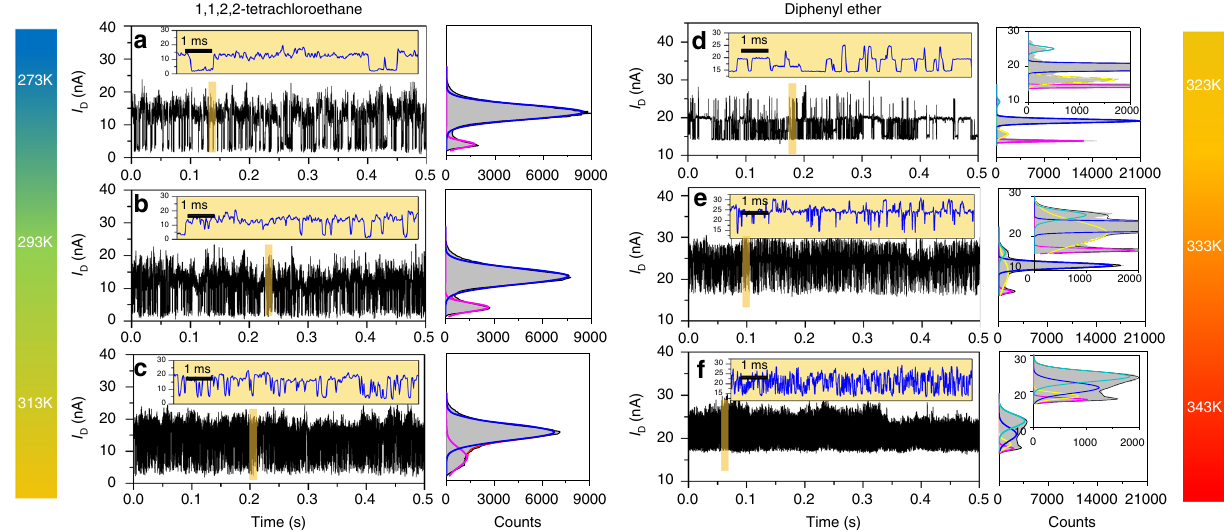
Fig. 3 Temperature-dependent and solvent-dependent measurements of hydrogen bond dynamics. I – t curves and the corresponding histograms of a HBB- SMJ device immersed in TeCA at 273 K ( a ), 293 K ( b ) and 313 K ( c ), and in diphenyl ether at 323 K ( d ), 333 K ( e ) and 343 K ( f ). Insets in I – t curves show the corresponding enlarged parts marked in yellow. Insets in the histograms amplify the details of the current distributions. V bias = 300